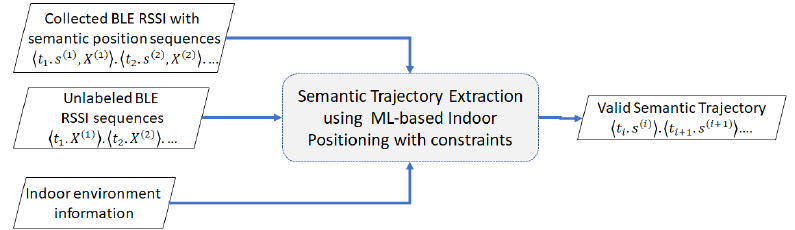
Figure 2. Problem definition to extract valid